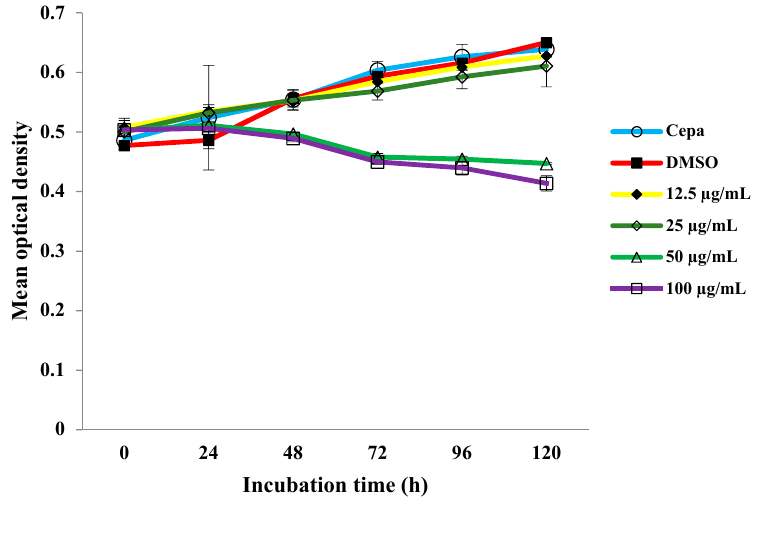
Figure 2. M. tuberculosis H37Rv exposed to different concentrations of